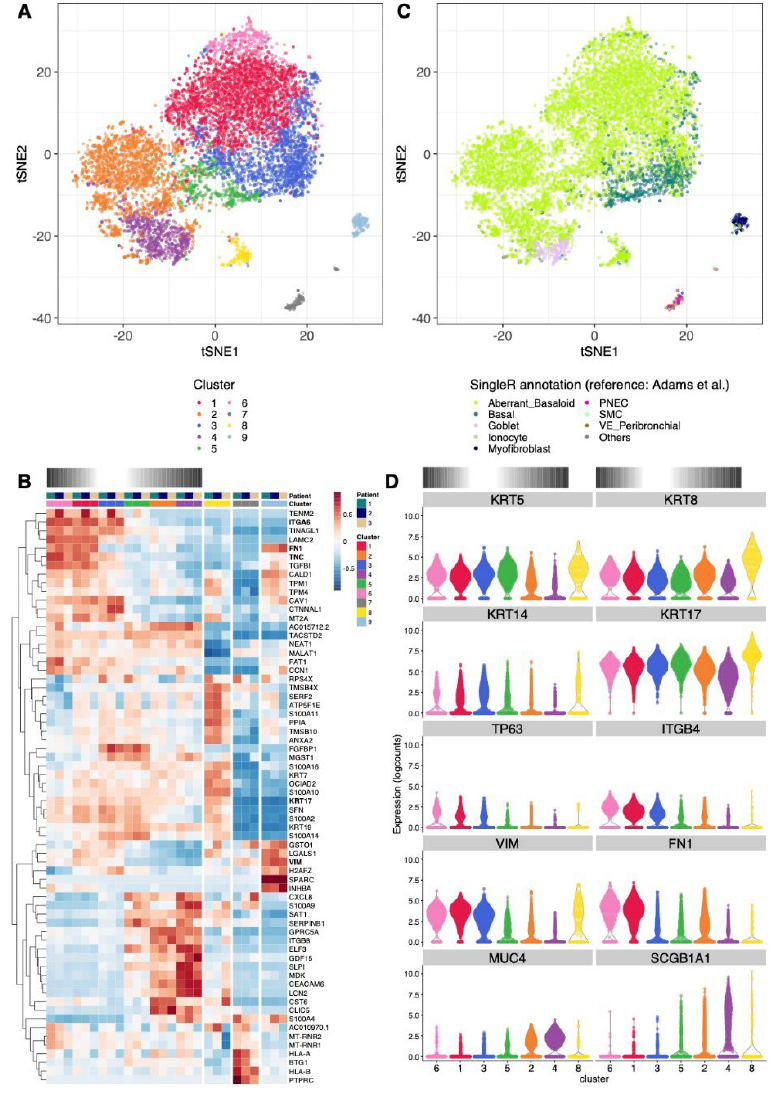
Figure 2. Clustering and cell type annotation of alveolar basal cells cultured in DMEM growth medium. ( A ) tSNE showing the separation of cells into nine clusters. ( B ) t-SNE showing the best matching cell type for each cell from the SingleR analysis using as reference the scRNA-seq dataset from Adams et al. [6]. Cell types represented by no more than 10 cells in our dataset were pooled into the category “Others”. Reference cell types originating from IPF or control patients are not distinguished in this figure, but see Supplement Figure S2A. ( C ) Relative expression across clusters and patients of the strongest cluster-specific genes. The log-normalized expression levels were averaged across cells from the same cluster and patient, and averaged values are then centered and scaled per gene. Clusters of epithelial cells are ordered along the presumed differentiation gradients described in the text, indicated with a gradient color bar on top of the heatmap. ( D ) Violin plot showing the log-normalized expression of basal cell marker KRT5, KRT17, KRT14, TP63, ITGB4, mesenchymal marker FN1 or VIM, secretory epithelial cell marker MUC4 or SCGB1A1 or transitional epithelial cell marker KRT8 across epithelial clusters. Only clusters of epithelial cells (i.e., without clusters 7 and 9) are shown, ordered along the presumed differentiation gradients described in the text, indicated with a gradient color bar on top of the